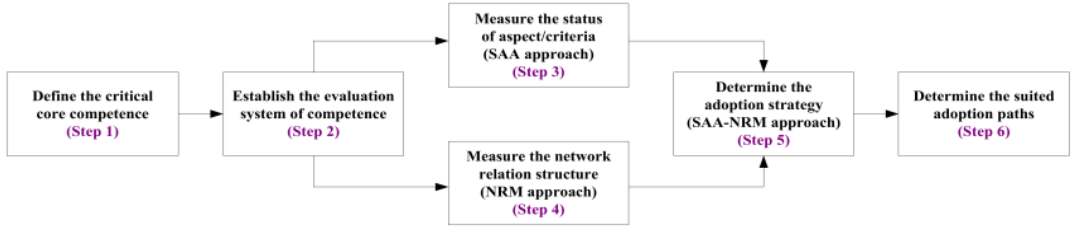
Figure 1. The SAA-NRM approach for core competence of SDM